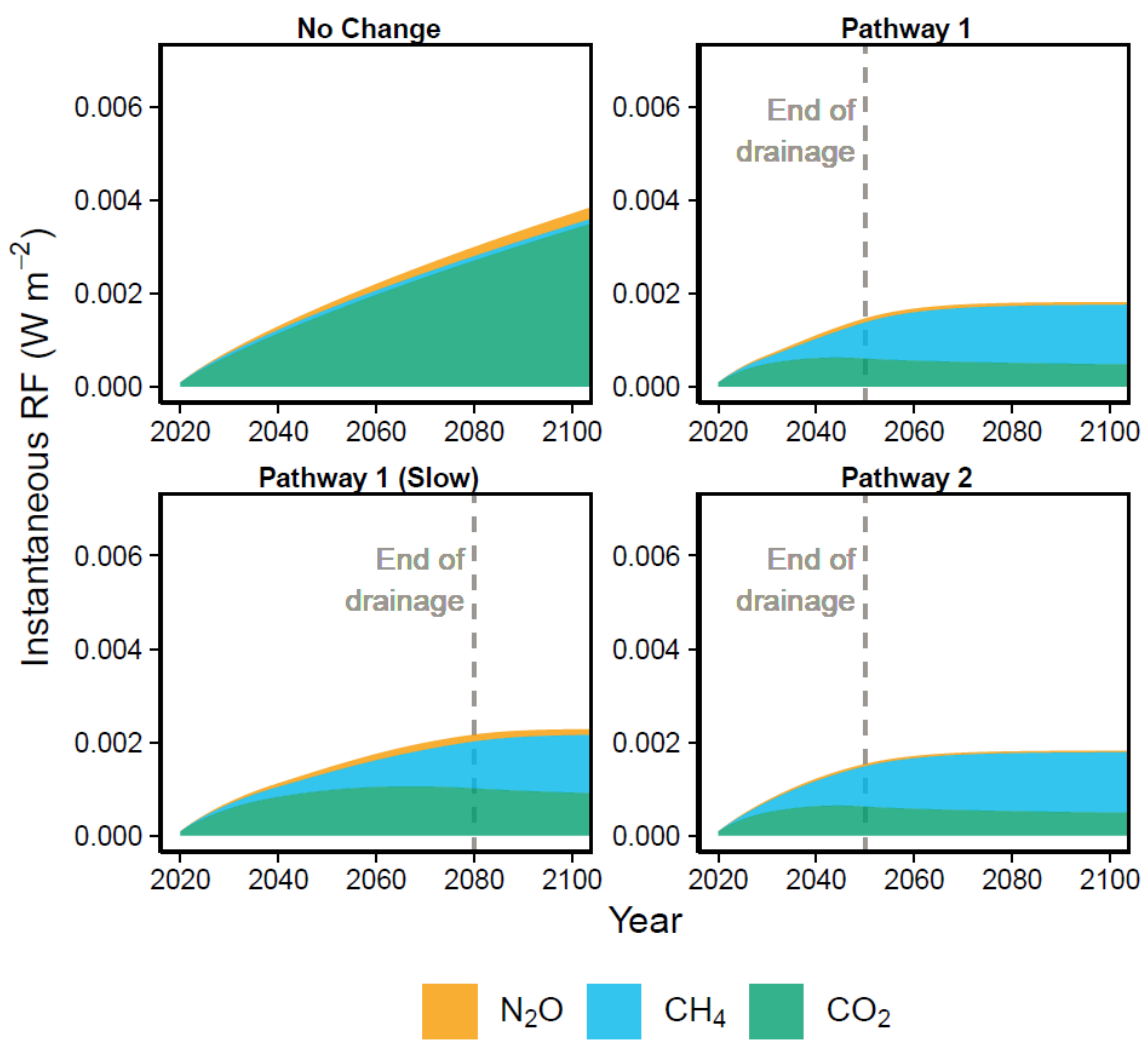
Figure 4. Climatic effects of peatland scenarios for Germany by greenhouse gas in the period until 2100. Contributions of the different greenhouse gases (nitrous oxide N 2 O, methane CH 4 , and carbon dioxide CO 2 ) to total radiative forcing (RF) are shown with estimated warming effects in the modelled